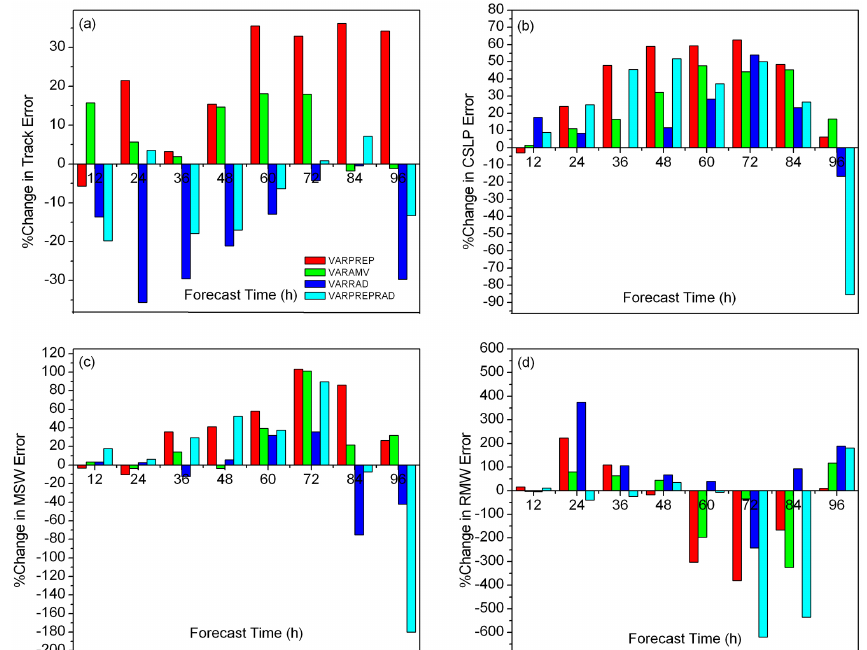
Figure 16. Error change in (a) track positions, (b) CSLP, (c) MSW and (d) RMW in 3D-Var experiments over control runs for all eight selected tropical cyclones. Positive values indicate improvement in simulation, i.e. errors are less with respect to